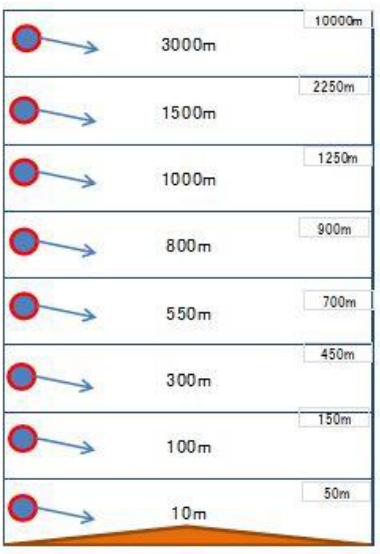
Figure 3. Box model of winds for the particle model Horizontal velocities are the same as wind data, while vertical velocities are Stokes equation as next.